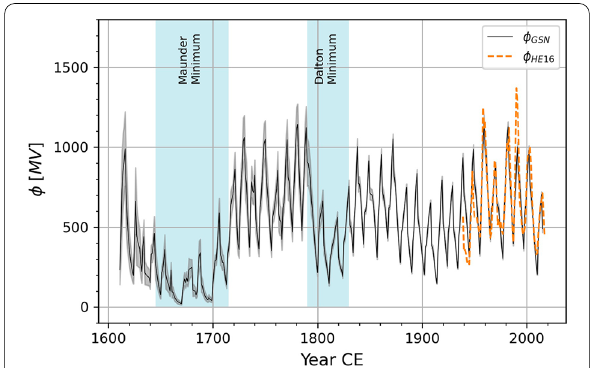
Fig. 1 Solar modulation potential since 1610 CE inferred from the GSN and neutron monitor data. The black line and the grey shading indicate the mean and 2-sigma uncertainty of the solar modulation potential inferred from the GSN (Svalgaard and Schatten 2016). The Grand Solar Minima are indicated by name and blue shadings. The solar modulation potential estimated from neutron monitor data (Herbst et al. 2017) from 1939 onwards is shown as an orange dashed